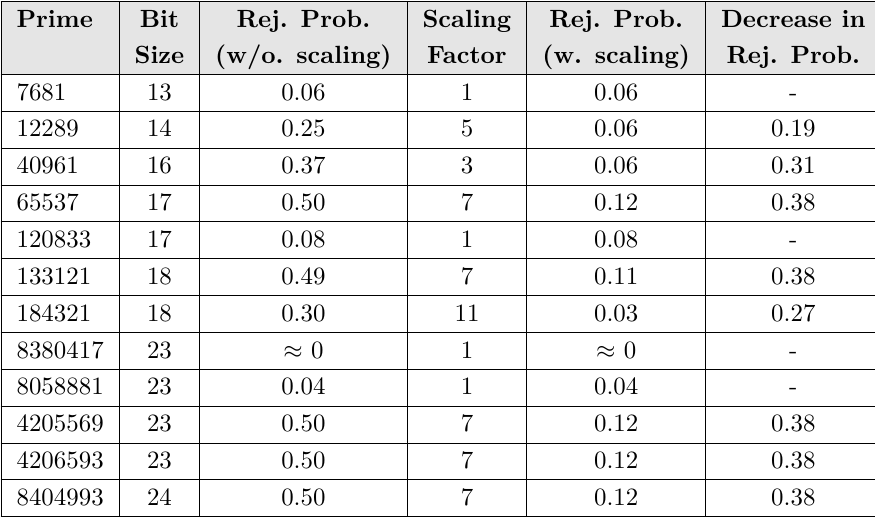
Table 3: Rejection probabilities for different primes with and without fast sampling Prime Bit Rej. Prob. Scaling Rej. Prob. Decrease in Size (w/o. scaling) Factor (w. scaling) Rej. Prob. 7681